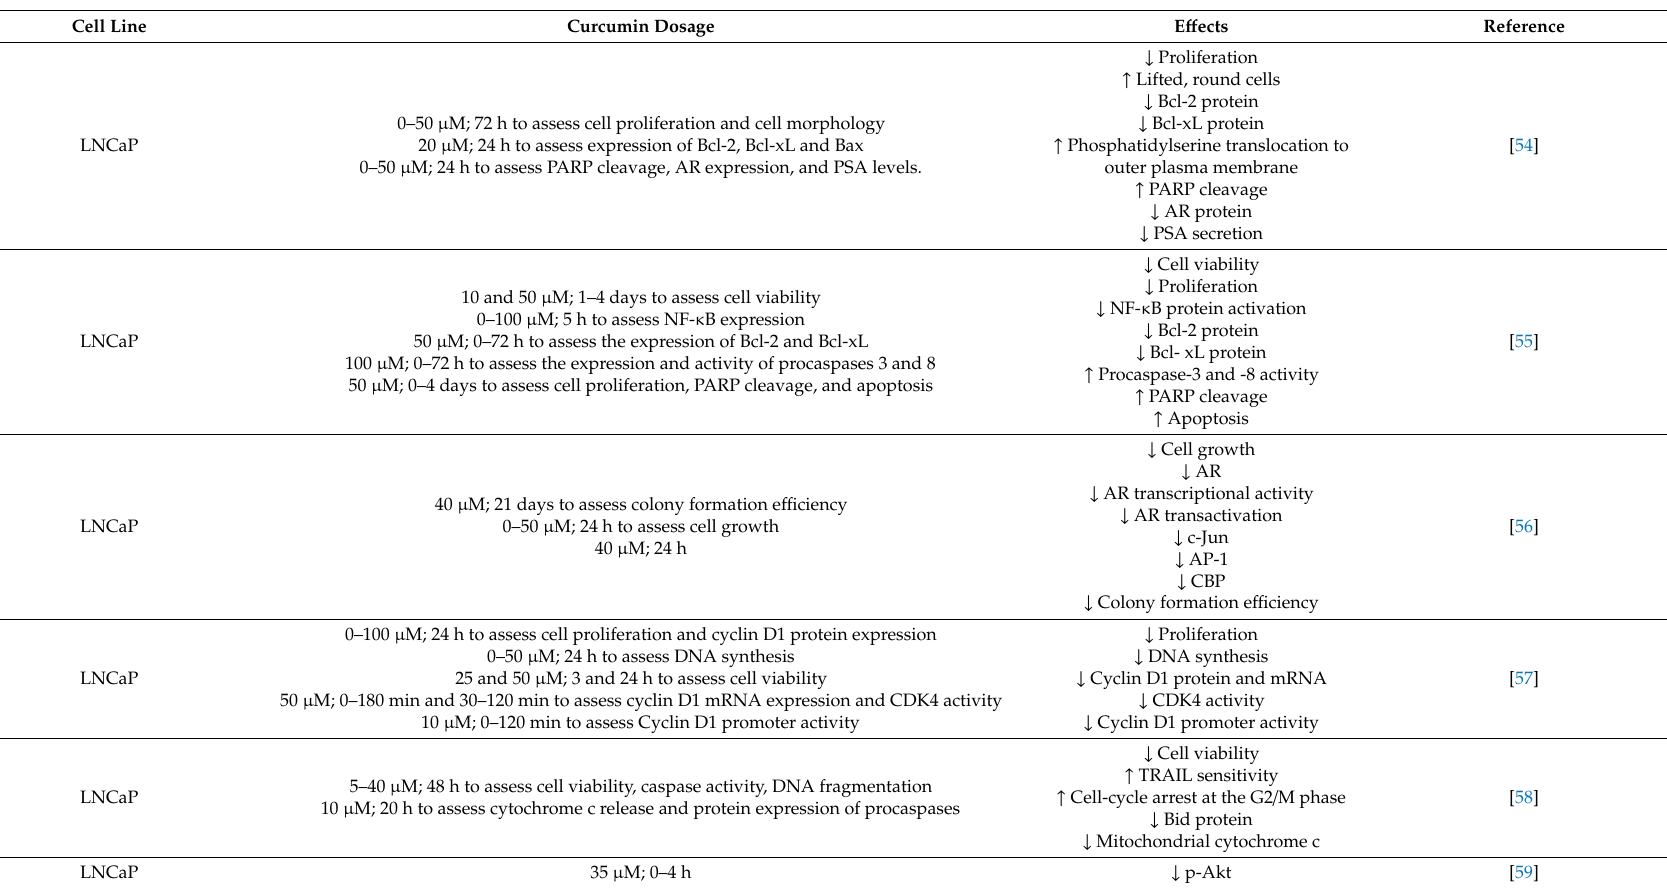
Table 3. In vitro evidence of the e ff ects of curcumin on androgen-sensitive prostate cancer